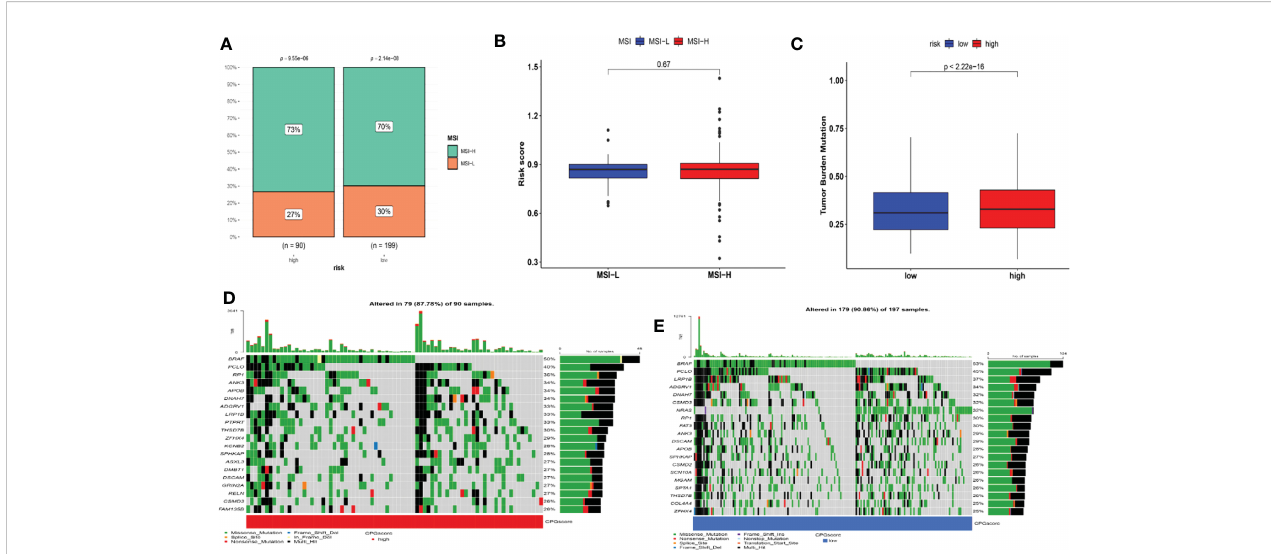
FIGURE 8 Detailed CRG score analysis in melanoma. (A – B) Relationships between CRG score and MSI. (C) TMB in various CRG score groups. (D – E) A waterfall plot of somatic mutation features with high and low CRG scores. Each column represented a different patient. The upper bar plot depicted TMB, and the number on the right indicated the frequency of mutation in each gene. The proportion of each variant type was shown in the right bar plot. MSI, microsatellite instability; TMB, tumor mutation